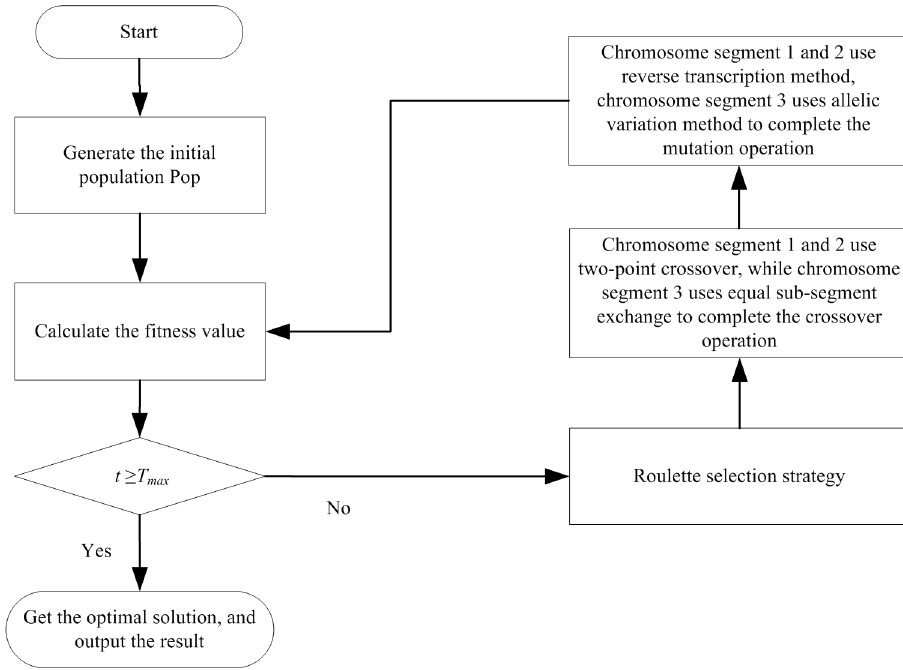
Fig 1. Flow diagram of the